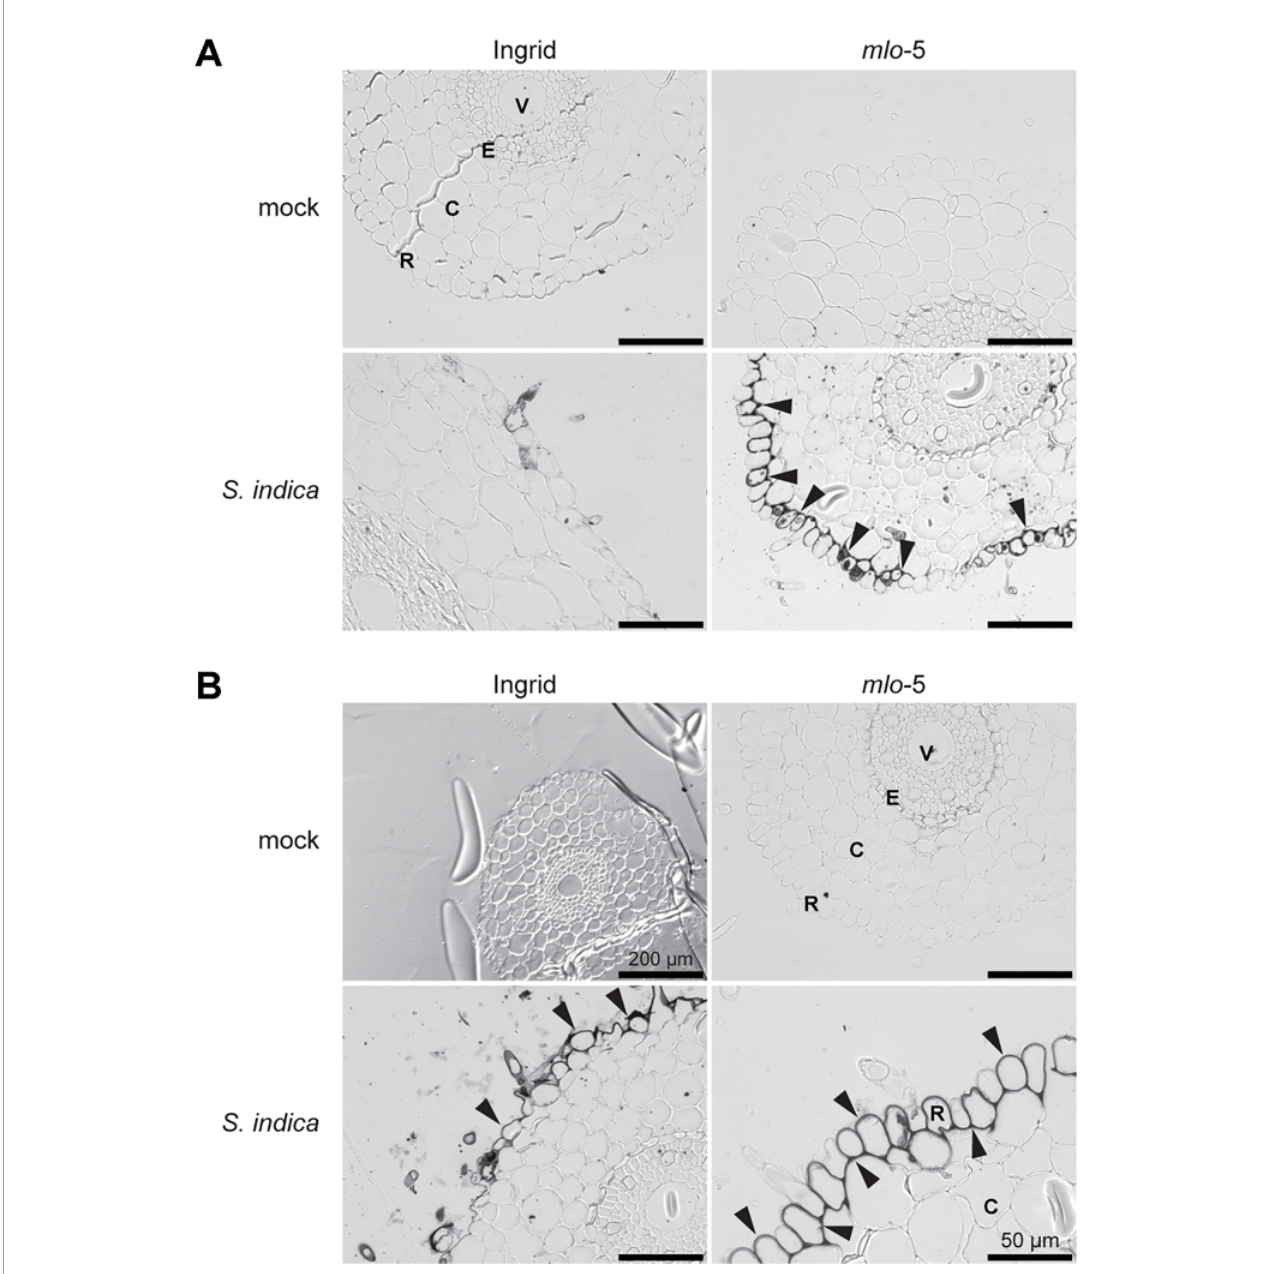
FIGURE 2 | Early accumulation of iron in the epidermal cells of the Ingrid mlo -5 mutant upon S. indica colonization. Light microscopic pictures show root sections stained with Perls/DAB at 5 (A) and 6 dpi (B) . Black precipitates, indicative of iron accumulation, appear around root epidermal cells in mlo -5 at 5 dpi, whereas iron accumulation in WT plants is only visible after 6 days of S. indica colonization (black arrowheads). Size bar = 100 µm unless otherwise indicated. R, rhizodermis; C, cortex; E, endodermis; V,